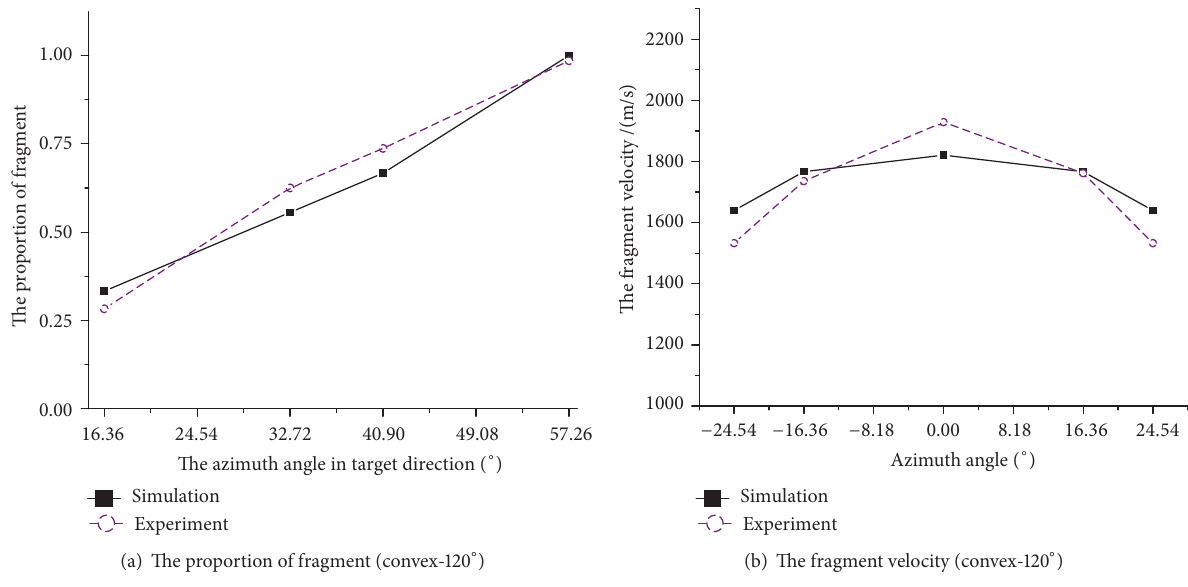
Figure 9: The simulation data and experiment data of convex-120 ∘